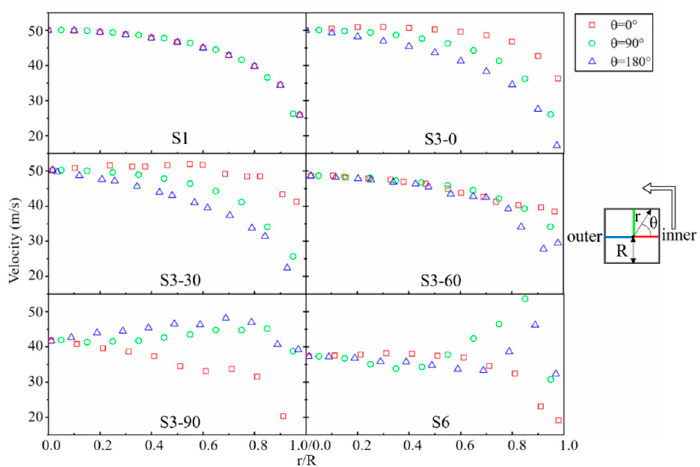
Figure 13. Time-averaged velocity profiles along different radial lines located at 90° intervals starting from θ = 0°.